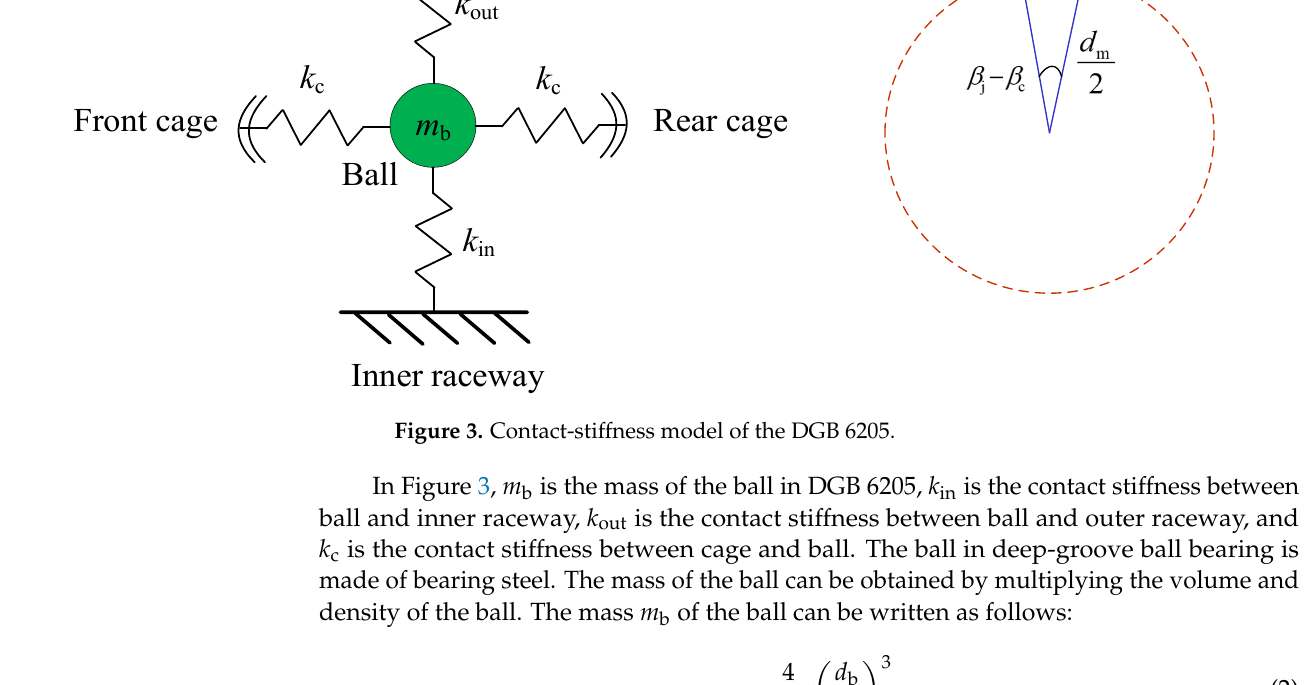
Table 1. Model parameters of the DGB 6205.